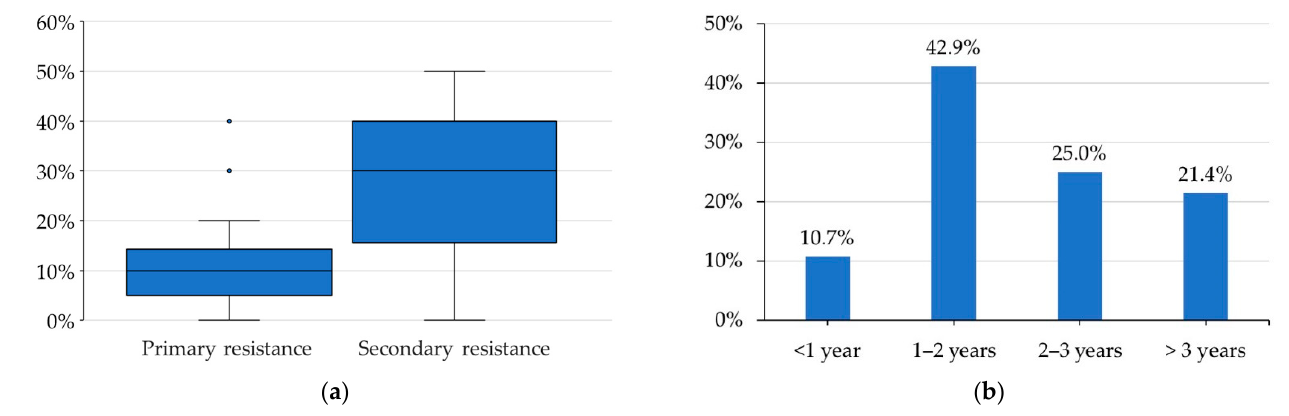
Figure 1. Participant responses: ( a ) Among your myelofibrosis patients who started ruxolitinib treatment, how many presented primary and secondary resistance? ( b ) Among patients who have experienced secondary resistance to ruxolitinib, after how long on average has there been a loss of response to the drug?